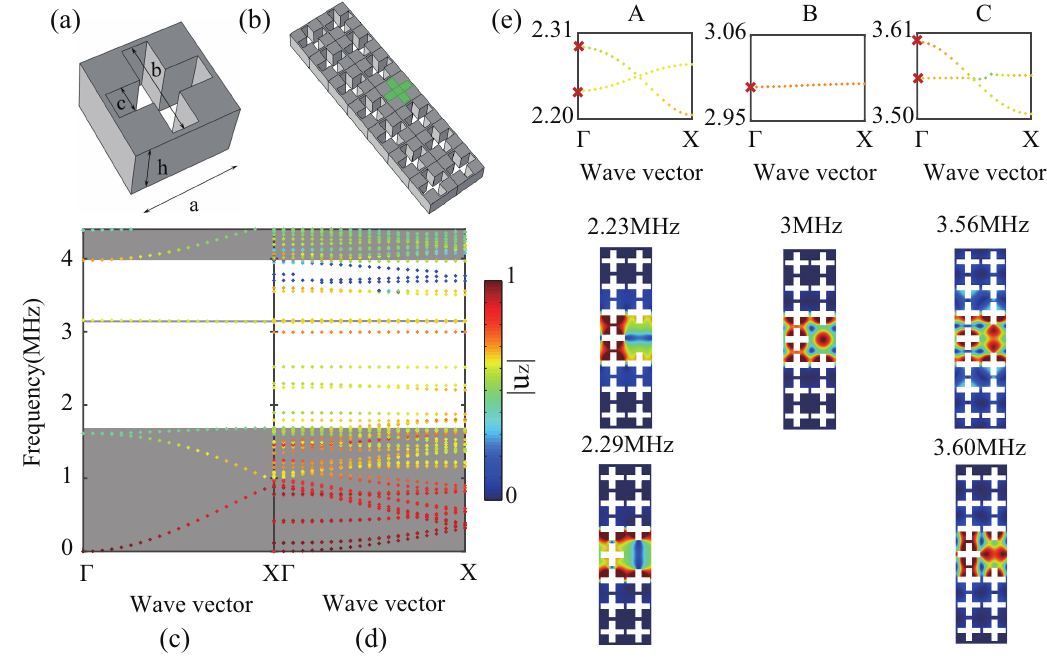
Figure 2. Dispersion of the phononic crystal slab of cross holes. ( a ) The primitive unit cell is defined by four parameters: the lattice constant a , the slab thickness h , the cross length b , and the cross width c . ( b ) A coupled-resonator elastic waveguide (CREW) is formed from defects separated by two lattice constants and created by omitting one hole. The depicted supercell has seven rows and two columns. ( c ) The band structure of the crystal is shown for out-of-plane modes only and for b / a = 0.9, c / a = 0.25, and h / a = 0.7. The complete bandgap appears between the gray regions. The color scale of the bands is proportional to the out-of-plane component of displacement. ( d ) The band structure of the CREW contains a series of flat (small dispersion) bands, each holding a guided Bloch wave. ( e ) Close-up views of three selected frequency ranges are shown. Eigenmodes at the Γ point of the first Brillouin zone are shown for each of the five